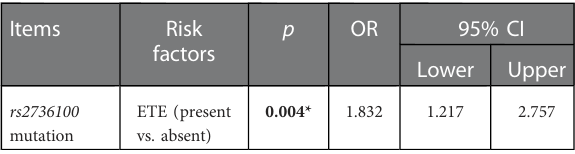
TABLE 2 Factors associated with the presence of TERT rs2736100 genetic polymorphism (TT vs. TG/GG) in multivariate analysis. Items Risk factors